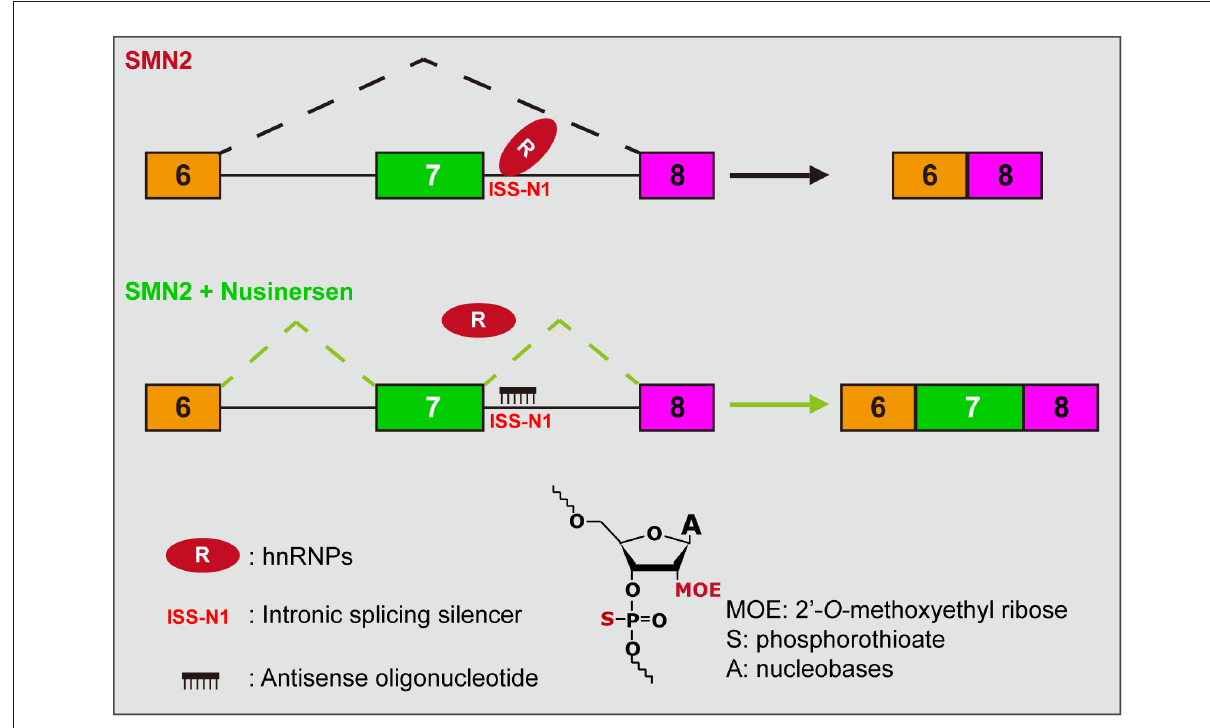
FIGURE2 Mechanism of action of nusinersen. The presence of an ISS (called ISS-N1) near the 5’SS at the SMN2 intron 7, combined with a repressor (hnRNP A1/2), inhibits the inclusion of exon 7, which results in the majority of splice products being SMN ∆ 7. Nusinersen is an antisense oligonucleotide that base-pairs with ISS-N1 to prevent the repressor binding, thereby promoting the inclusion of exon 7. The lower part of the diagram presents the chemical structure formula of ASO, where the hydroxyl group on the second carbon is replaced by MOE and an oxygen atom on the phosphate group is replaced by a sulfur atom compared to